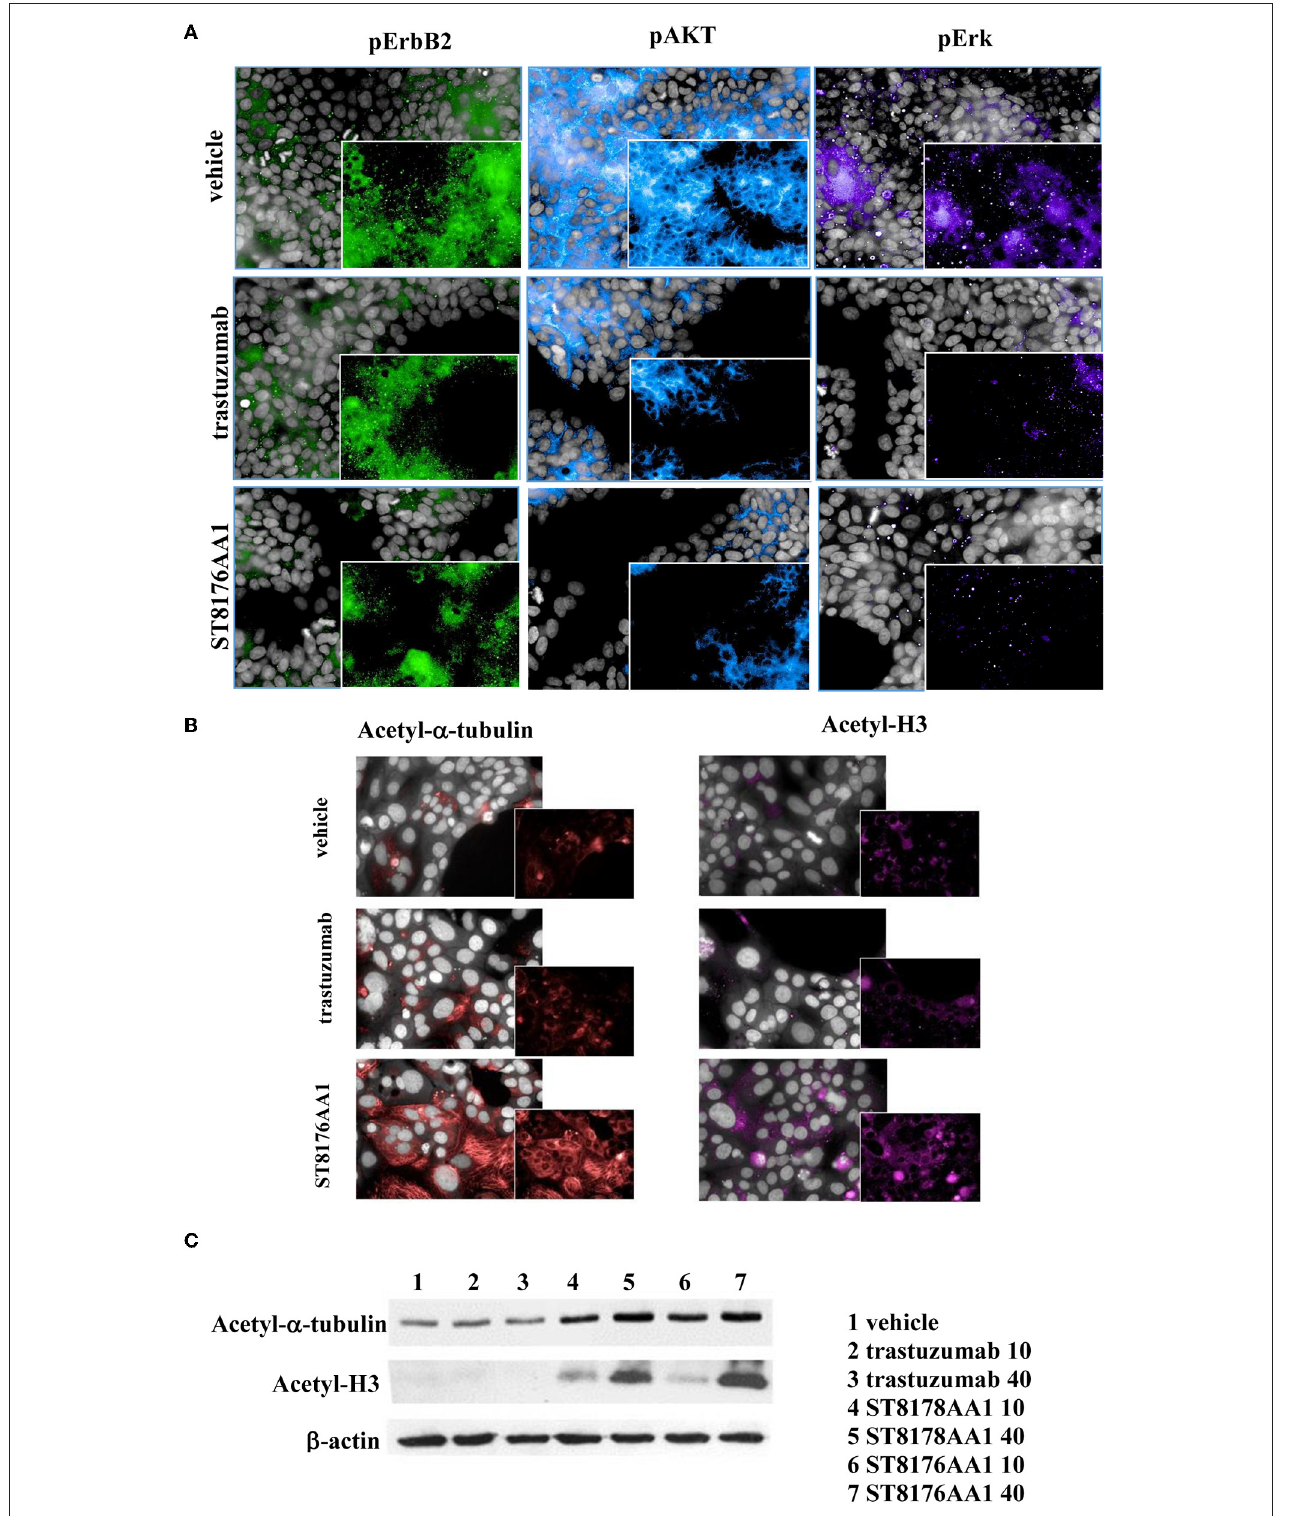
FIGURE 3 | ST8176AA1 inhibits ErbB2 signaling and upregulates acetylation of histones and alpha-tubulin in tumor cells. (A) HCS imaging showing phosphorylation of ErbB2 and downstream molecules in heregulin (20ng/mL)-activated LS174T human colon carcinoma cells. ST8176AA1 and trastuzumab were used at 30 µ g/mL (24-h incubation). (B) HCS imaging showing acetylation of alpha-tubulin (red) and histone H3 (fuchsia) in Capan-1 (pancreas carcinoma) cells. ST8176AA1 and